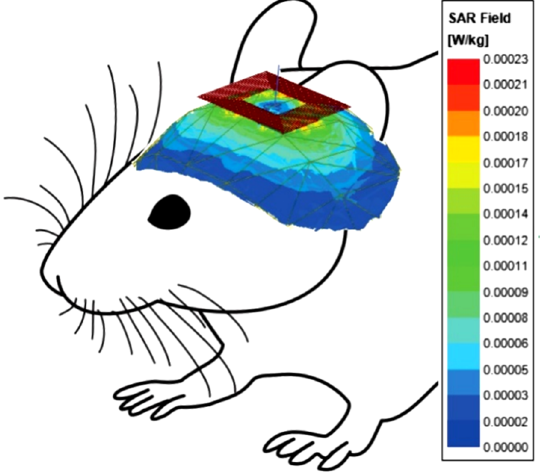
Figure 11. 3D SAR simulation for a living tissue for bio-medical compatibility.